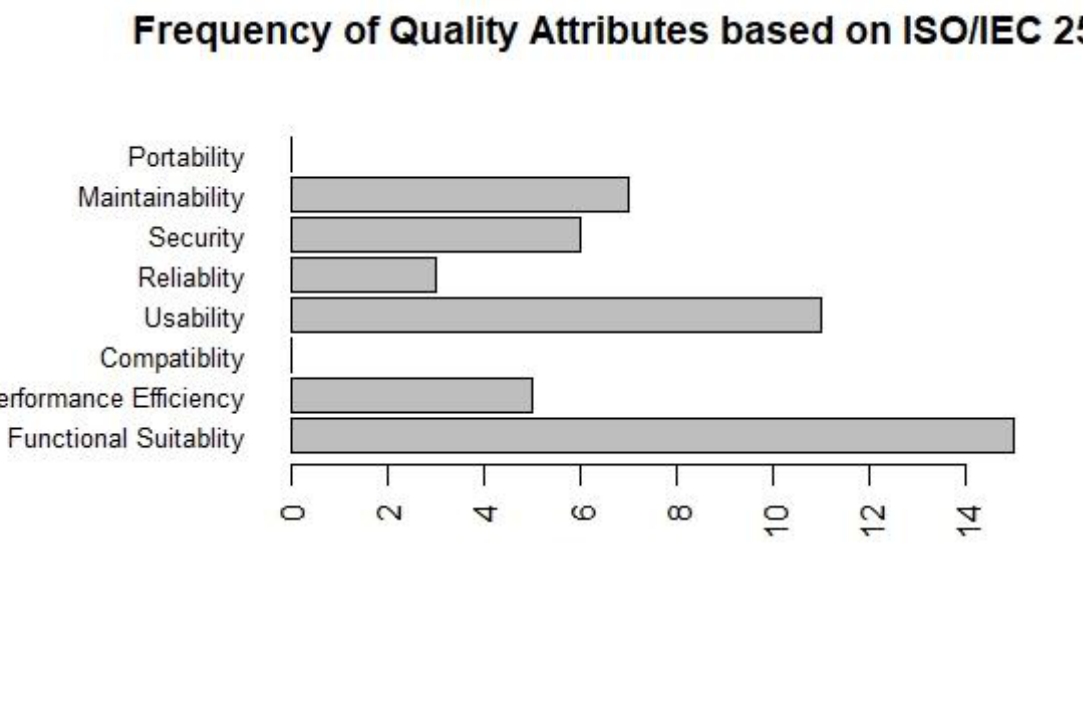
Figure 6. Frequency of mentioned ISO/IEC 25010 quality